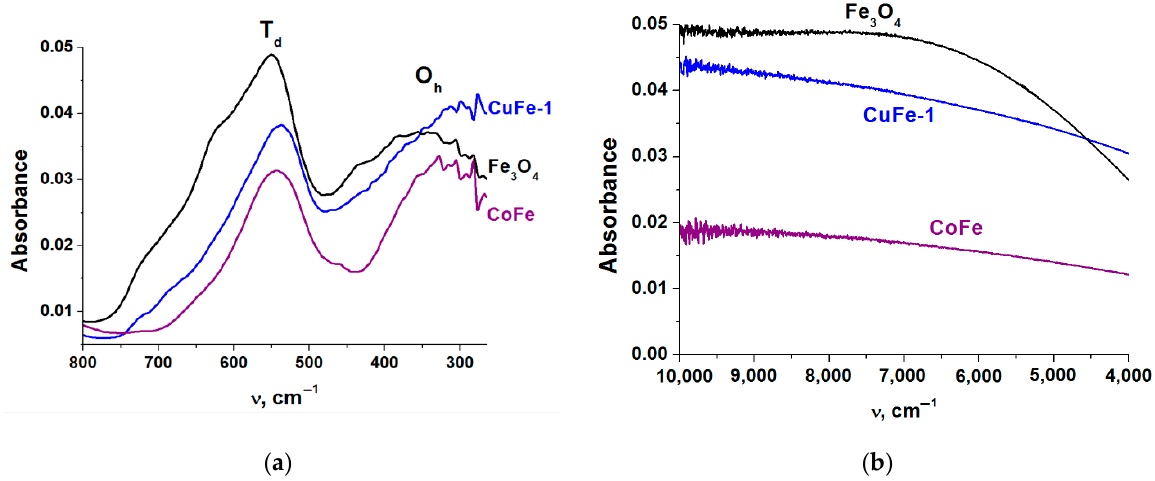
Figure 2. The spectra of Fe 3 O 4 , copper ferrite (CuFe-1) and cobalt ferrite (CoFe) in the region of vibrations of metal–oxygen bonds ( a ) and in the near-infrared region ( b ).